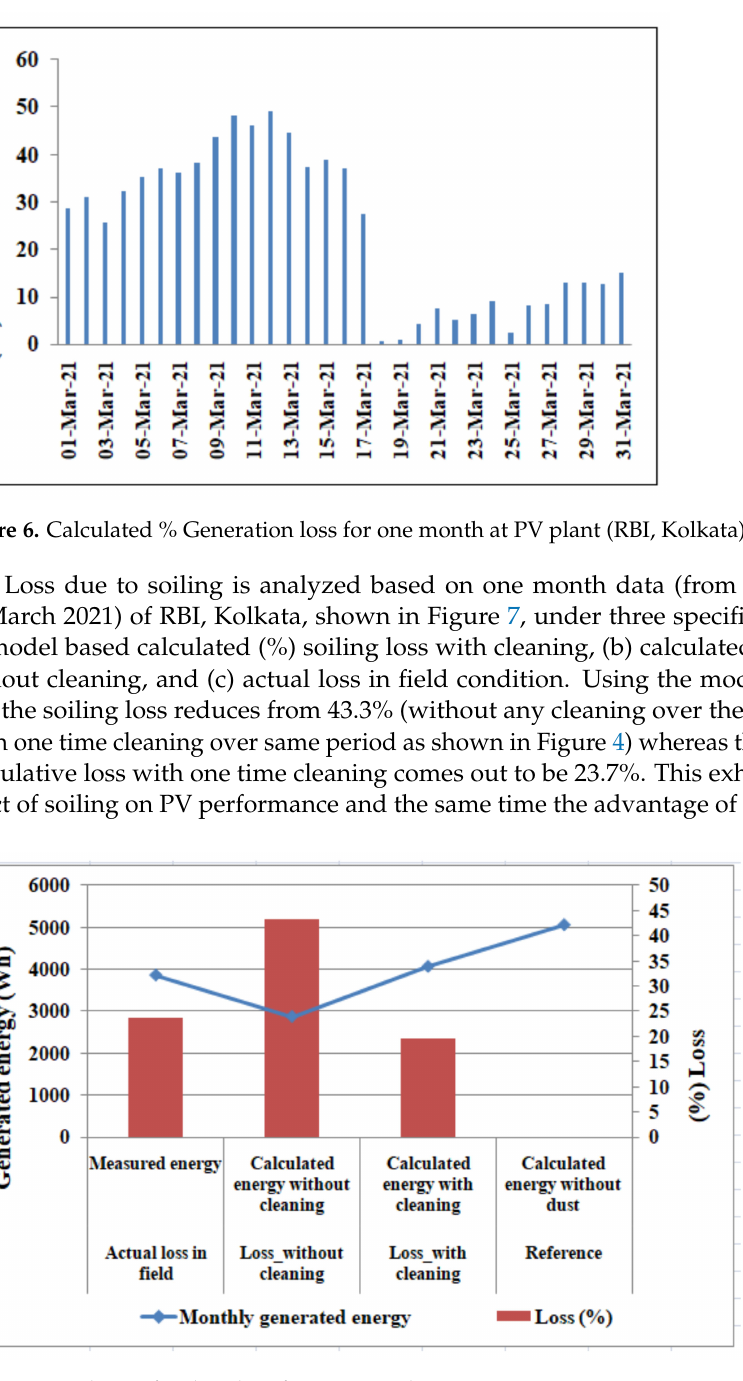
Figure 7. Analysis of soiling loss for one